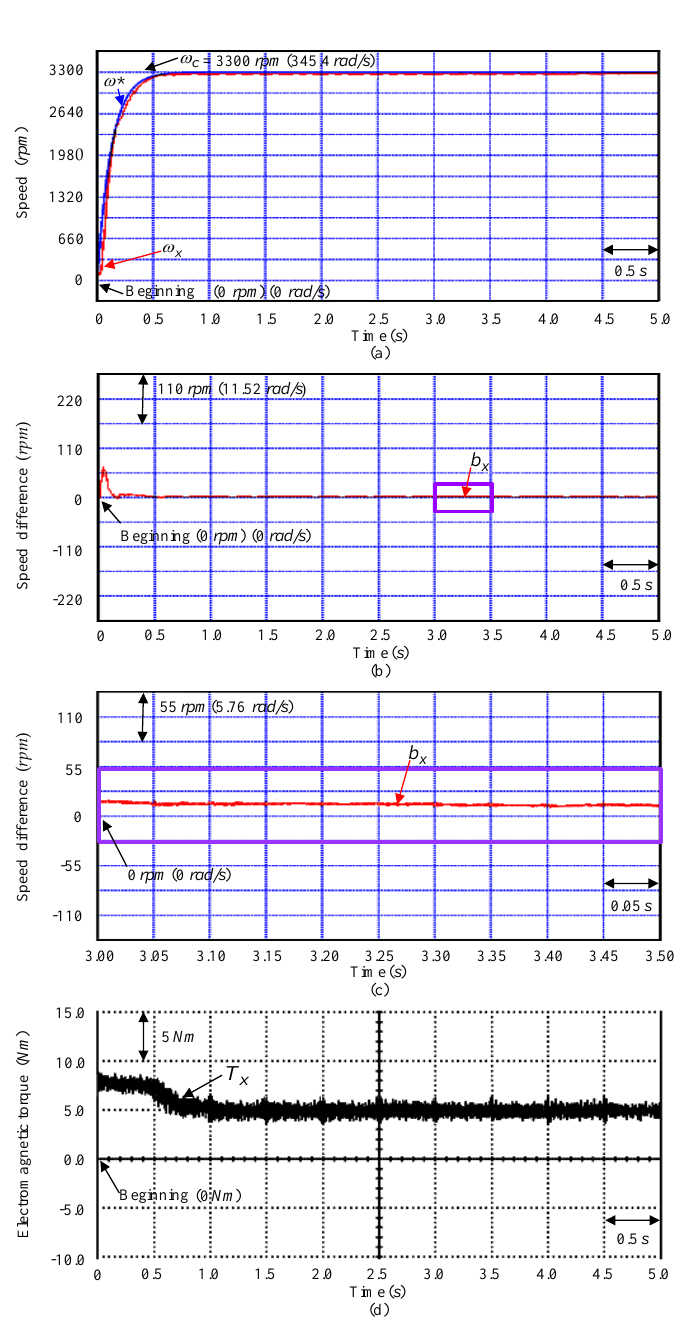
Figure 9. Tested instances with experimental results obtained by using the controller CD2 for the SSCCRIM impelled continuously variable transmission assembled system at the examination Y2 instance: ( a ) speed response, ( b ) speed difference response, ( c ) enlargement of speed difference response, ( d ) electromagnetic torque response .